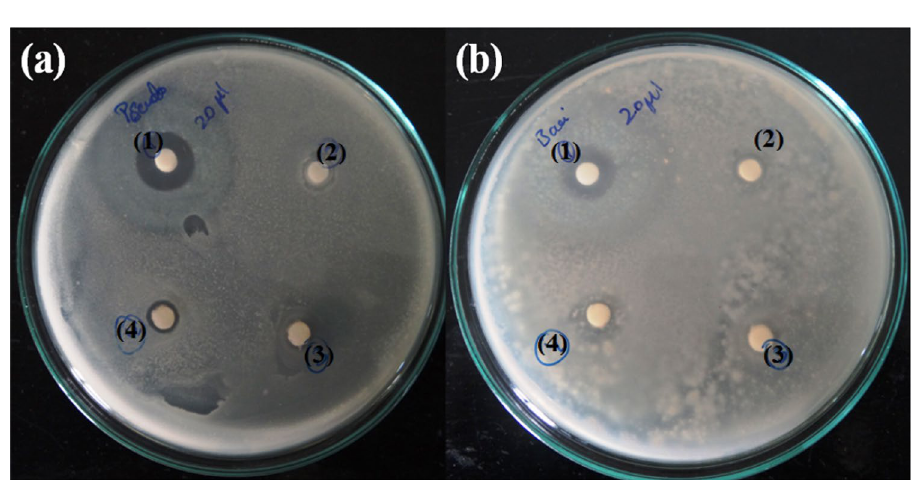
Fig. 6 Antibacterial activity of